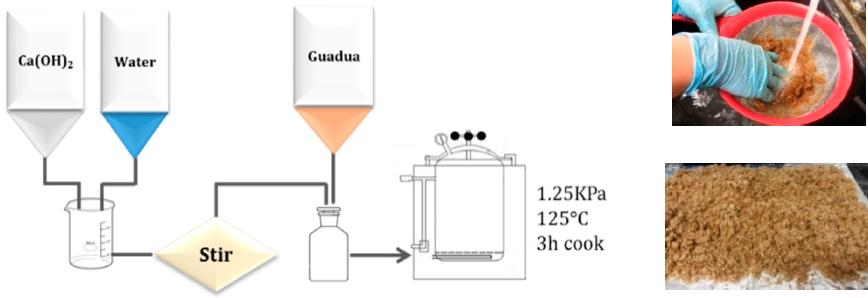
Figure 3. Ca(OH) 2 treatment process for the G. angustifolia samples.